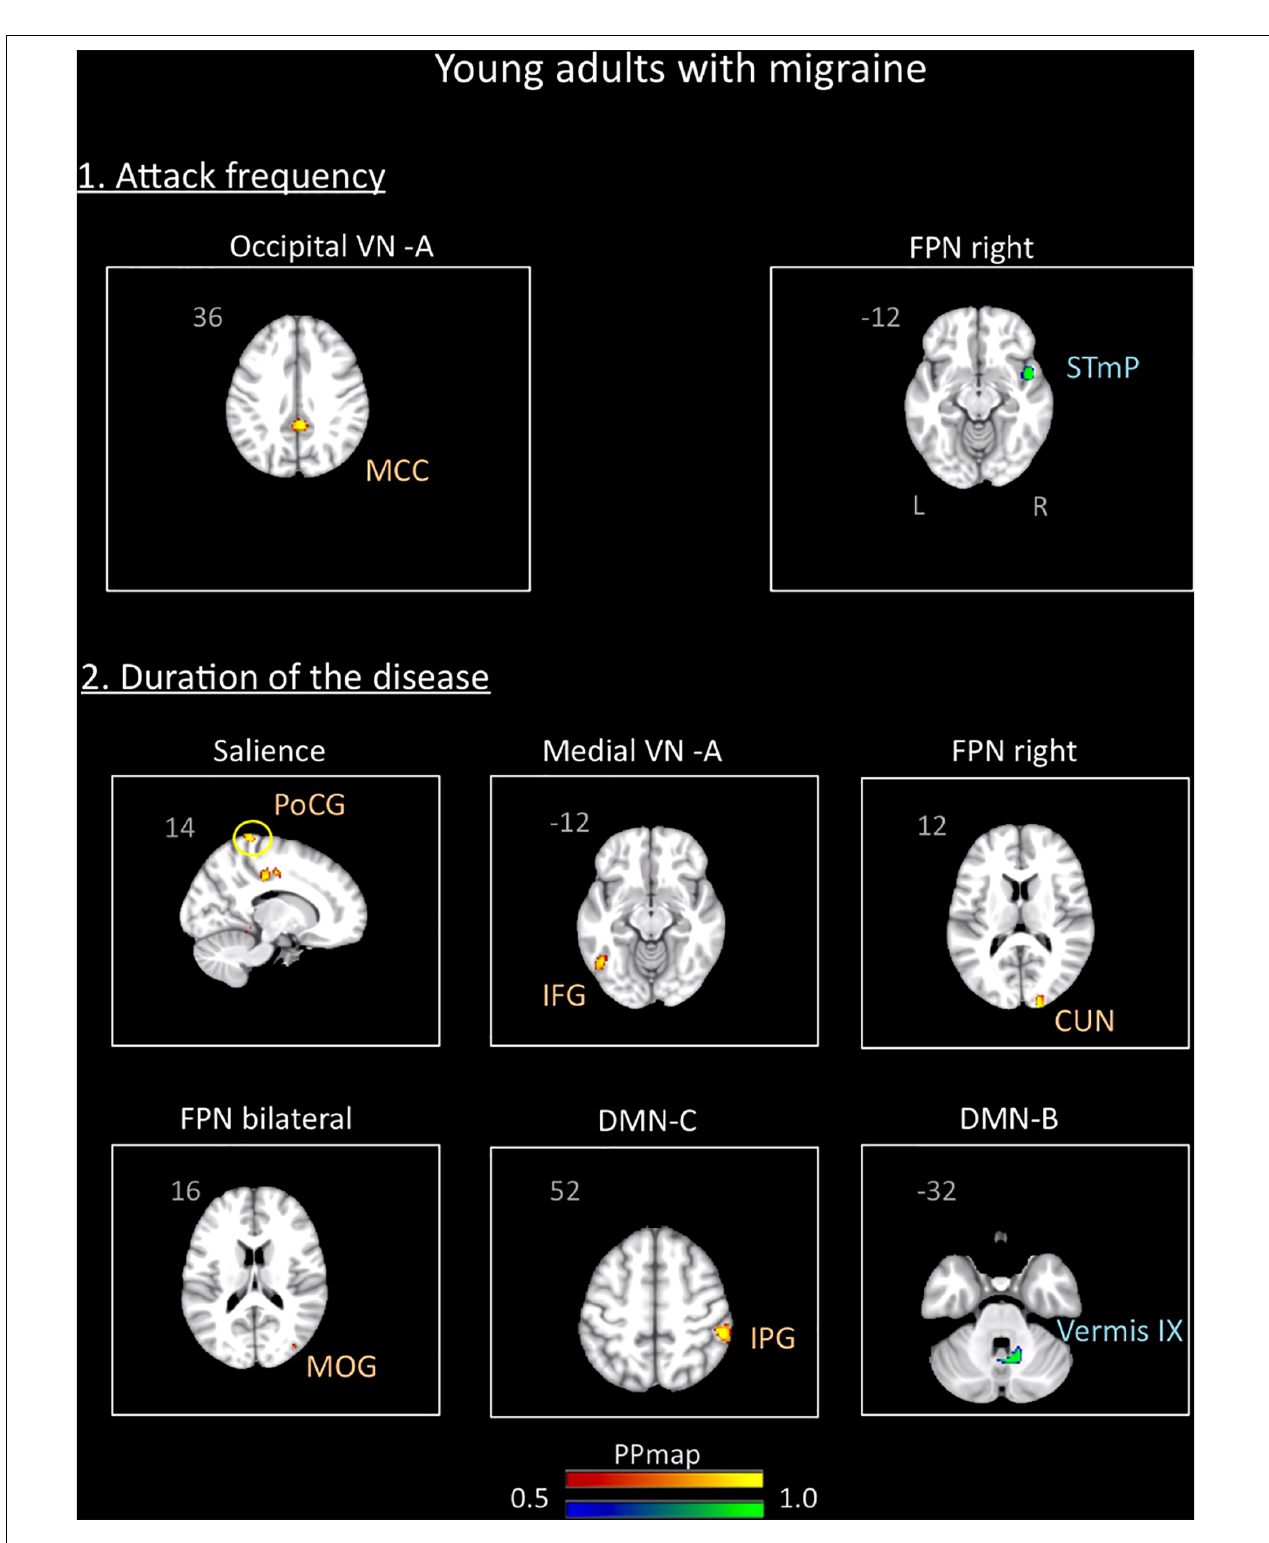
FIGURE 7 | Association between the rs-FC of the young adults with migraine and two clinical indicators of the disease: attack frequency (per month) and duration of the disease (in years). The figure shows significant positive association between attack frequency and the occipital visual A network and negative association with the right frontal parietal network. The duration of the disease was positively associated with the salience, medial visual A, right frontal parietal, bilateral frontal parietal, and default mode C networks and negatively associated with the default mode network B. See text for further details and Supplementary Table 2 . Numbers refer to the standard MNI Atlas coordinates. Abbreviations of brain regions are described in Table 8